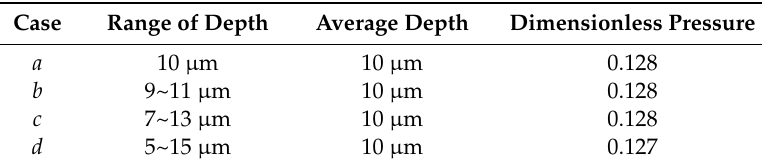
Table 3. Comparison of di ff erent dimple